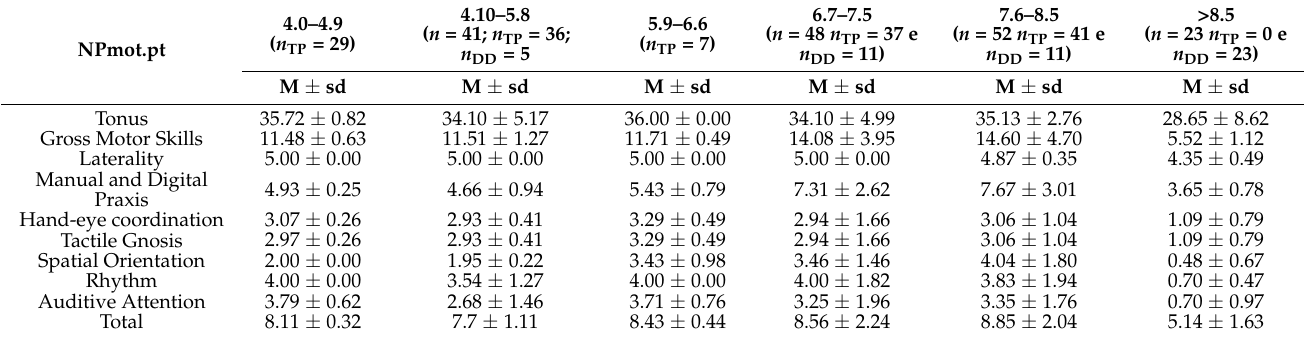
Table 8. Mean and standard deviation of NPmot.pt domains by age.